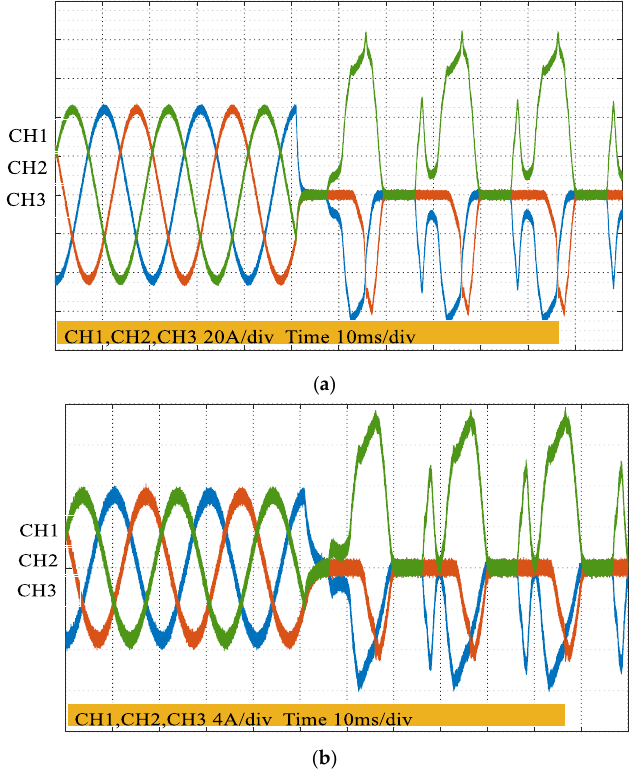
Figure 5. S1 open-circuit faults: ( a ) output current is 44 A, ( b ) output current is 8.8 A.